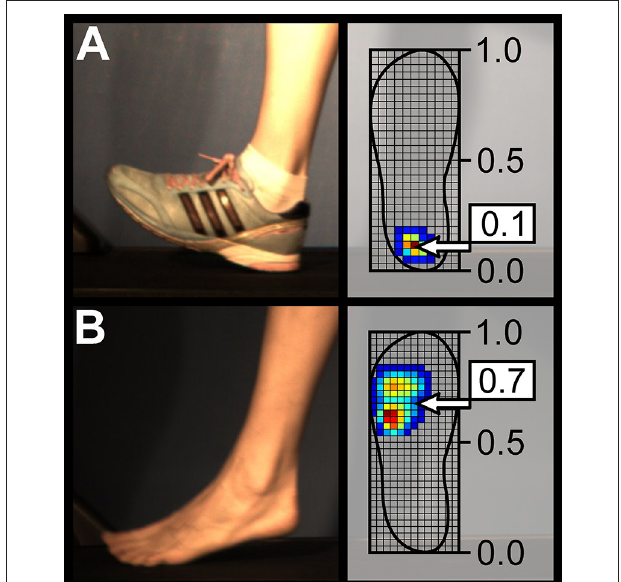
FIGURE 1 | Example of two fundamental synergies combined into one. The histograms in the panels A,B represent the two fundamental sets of motor modules and the curves in the panels D,E the two respective primitives, with arbitrary x- and y-axis units. The combined motor modules and primitives are shown in panels C,F , respectively.